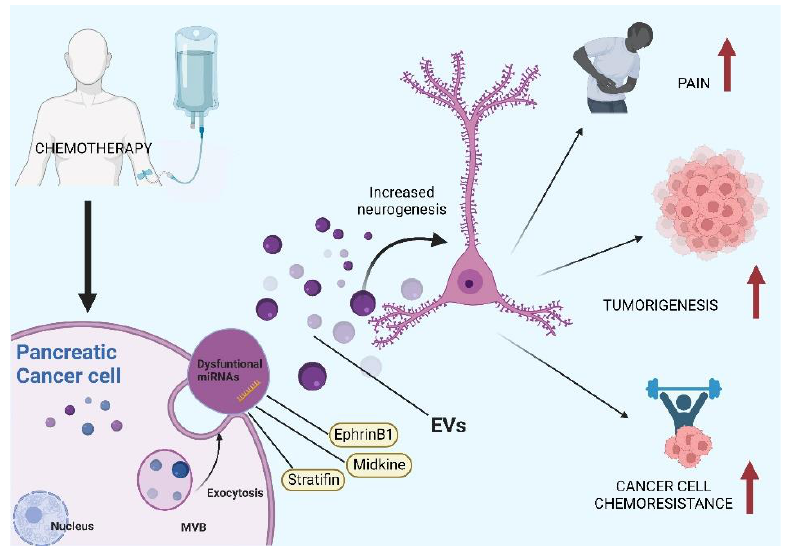
Figure 3. Possible role of extracellular vesicles in pancreatic cancer’s perineural invasion. Extracellular vesicles (EVs); multivesicular body (MVB).